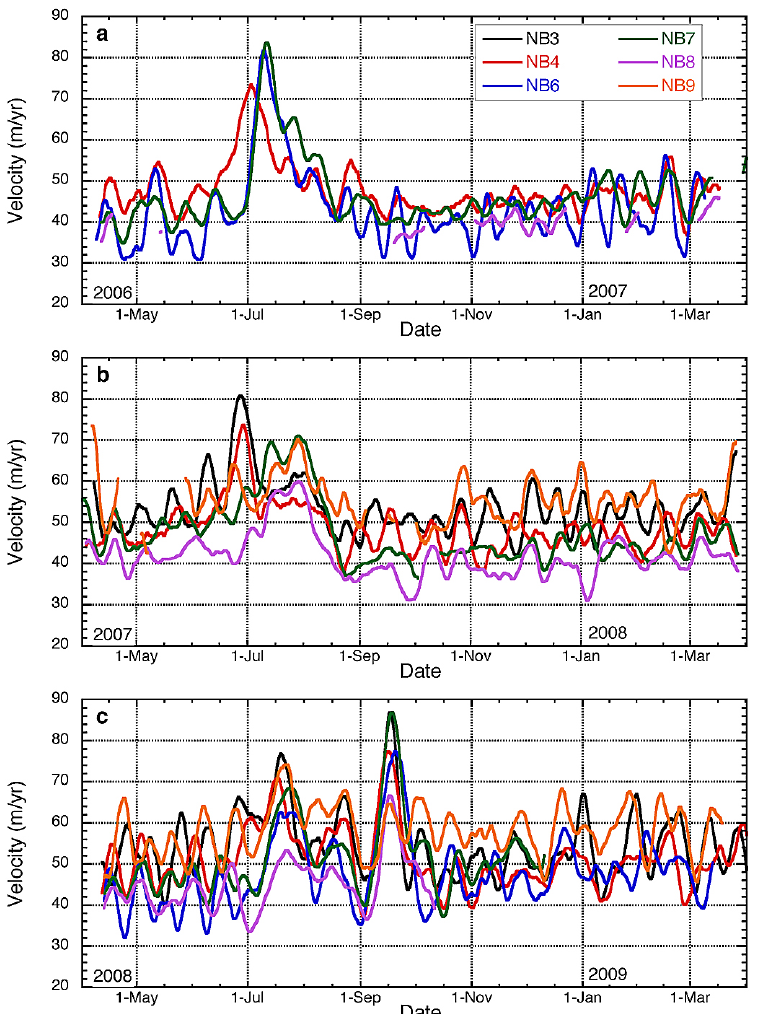
Fig. 6. Time series of velocity measurement of the stations on the central flow-line for the period 2006–2007 (a) , 2007–2008 (b) and 2008–2009 (c) . A running average of 240h is